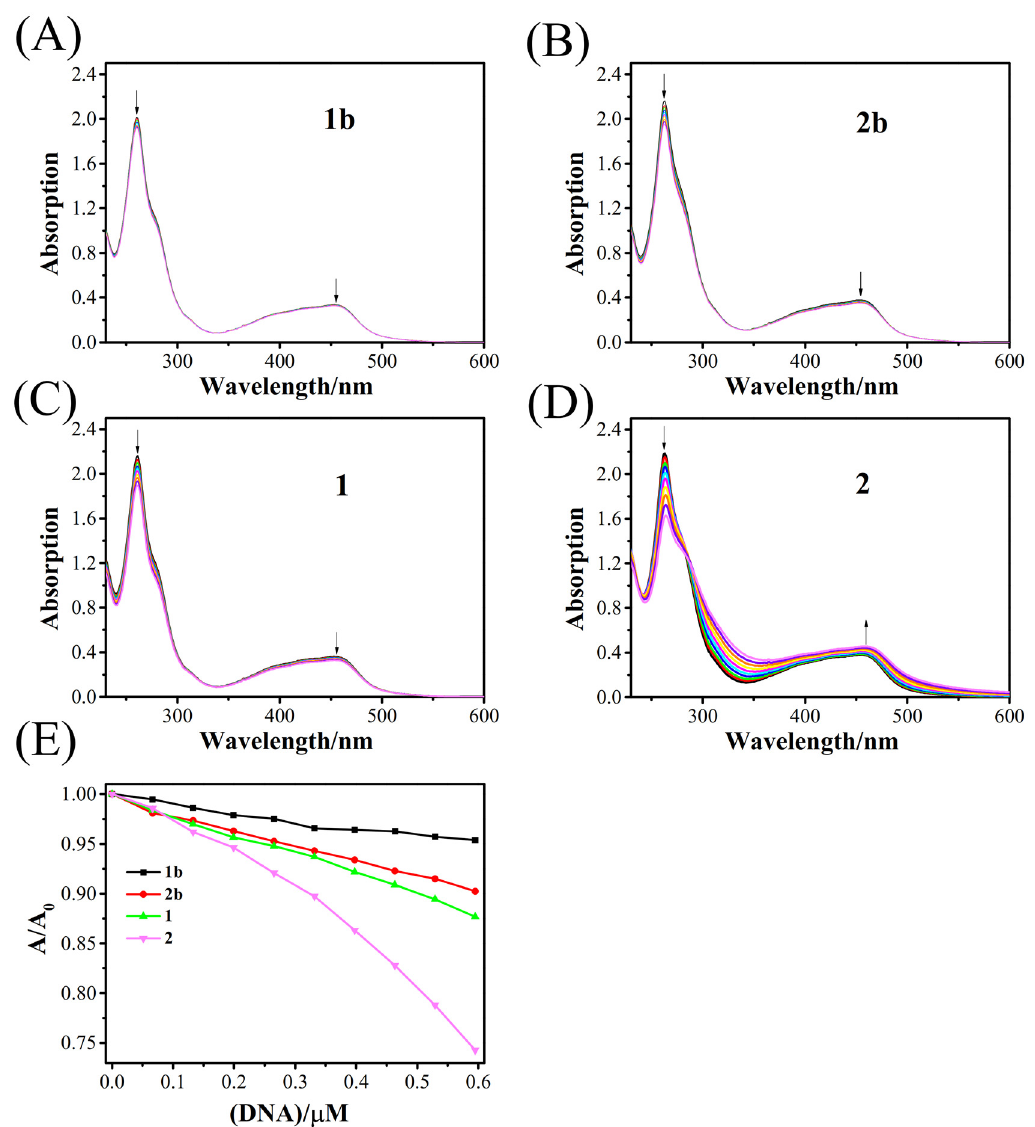
Figure 2. ( A – D ) Electronic spectra of 1b ( A ), 2b ( B ), 1 ( C ), and 2 ( D ) combined with c-myc G4 DNA in Tris-HCl-KCl buffer solution at pH 7.2. The arrow shows the change in absorbance intensity as the concentration of DNA increases. ( E ) The absorbance intensity of 1b , 2b , 1 , and 2 with increasing concentrations of c-myc G4 DNA. ([Ru] = 20 μ M, [ c-myc G4 DNA] = 100 μ M).